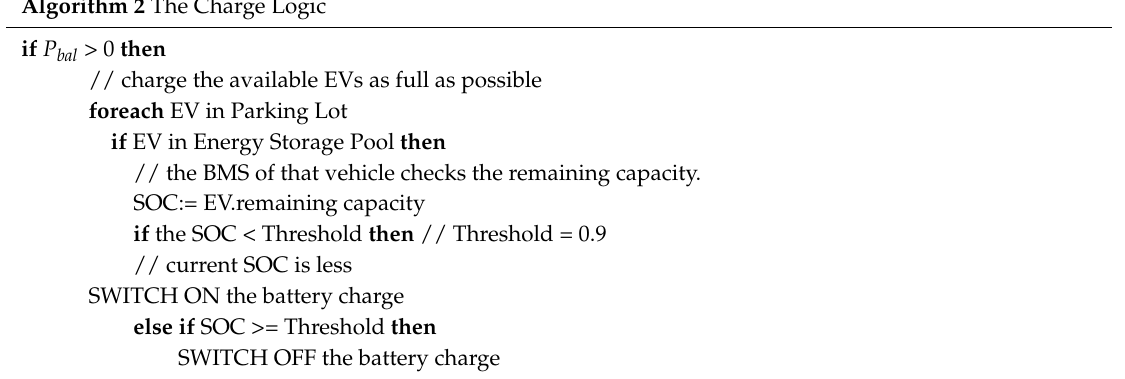
Algorithm 2 The Charge